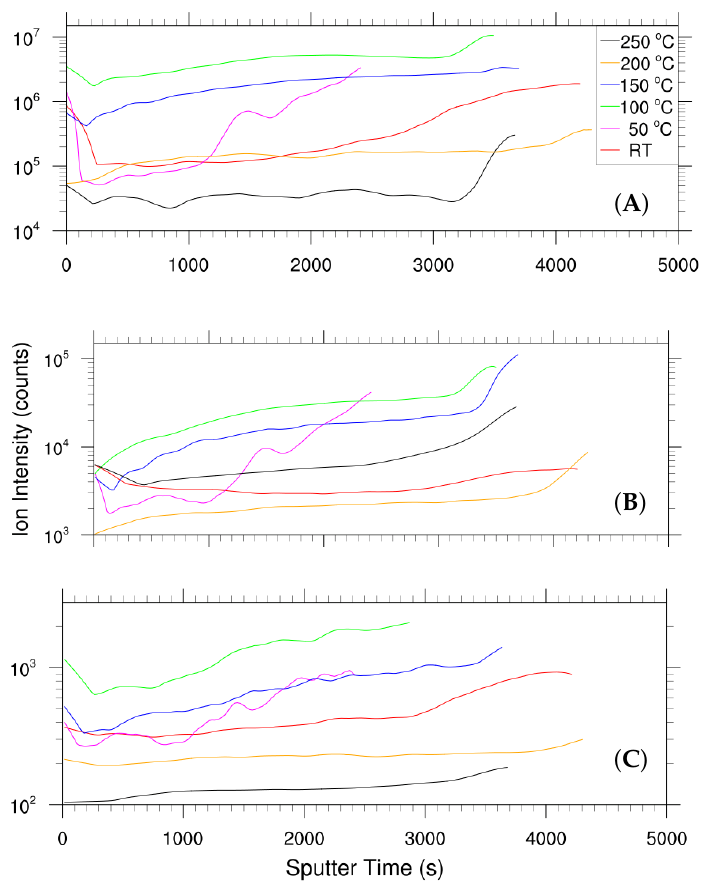
Figure 1. SIMS depth profiles of ( A ) Sodium, ( B ) Potassium, and ( C ) Oxygen in the molybdenum thin films for different substrate